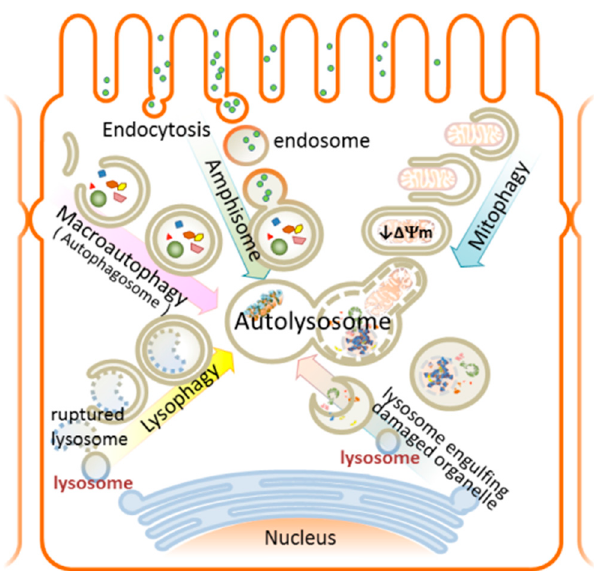
Figure 3. Autophagy contributes to protein degradation and damaged organelle removal in renal tubule cells. Active endocytosis occurs in the renal tubule cells for kidney ultrafiltrate reabsorption. Amphisome, a form of autophagic vacuole, is formed by fusion of an endosome with an autophagosome. Macroautophagy is triggered by the activation of an autophagic protein complex that induces LC3 recruitment to the nascent autophagosome (isolation membrane). Proteins that are committed for degradation are labeled by polyubiquitin chains and delivered to the autophagosome by the p62 scaffold protein. Fusion of autophagosomes and lysosomes, known as autolysosomes, results in the degradation of the contents. Selective autophagy like mitophagy and lysophagy are used to remove damaged mitochondria (depolarization of inner mitochondrial membrane) or ruptured lysosome, respectively, during tubule cell injury.